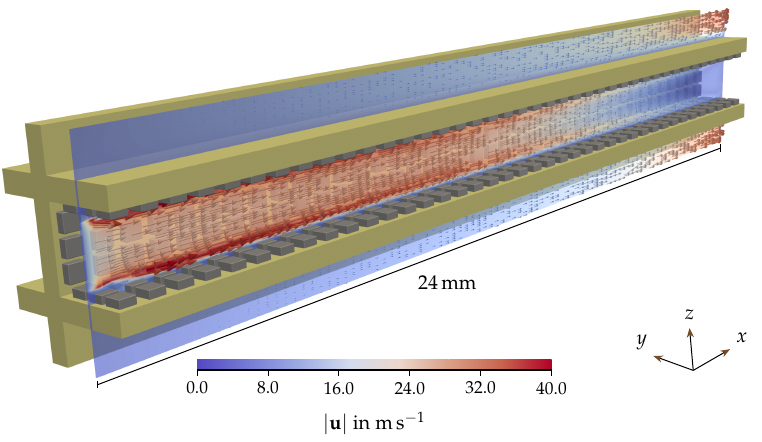
Figure 18. Flow field with uniformly fragmented PM layer in gray. Dark yellow structures represent porous filter substrate. Colour scale indicates local velocity